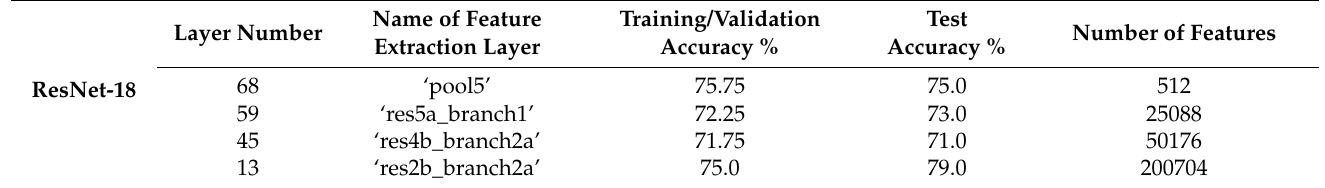
Table 9. Classification performance of SVM using the autonomous features from ResNet-18.